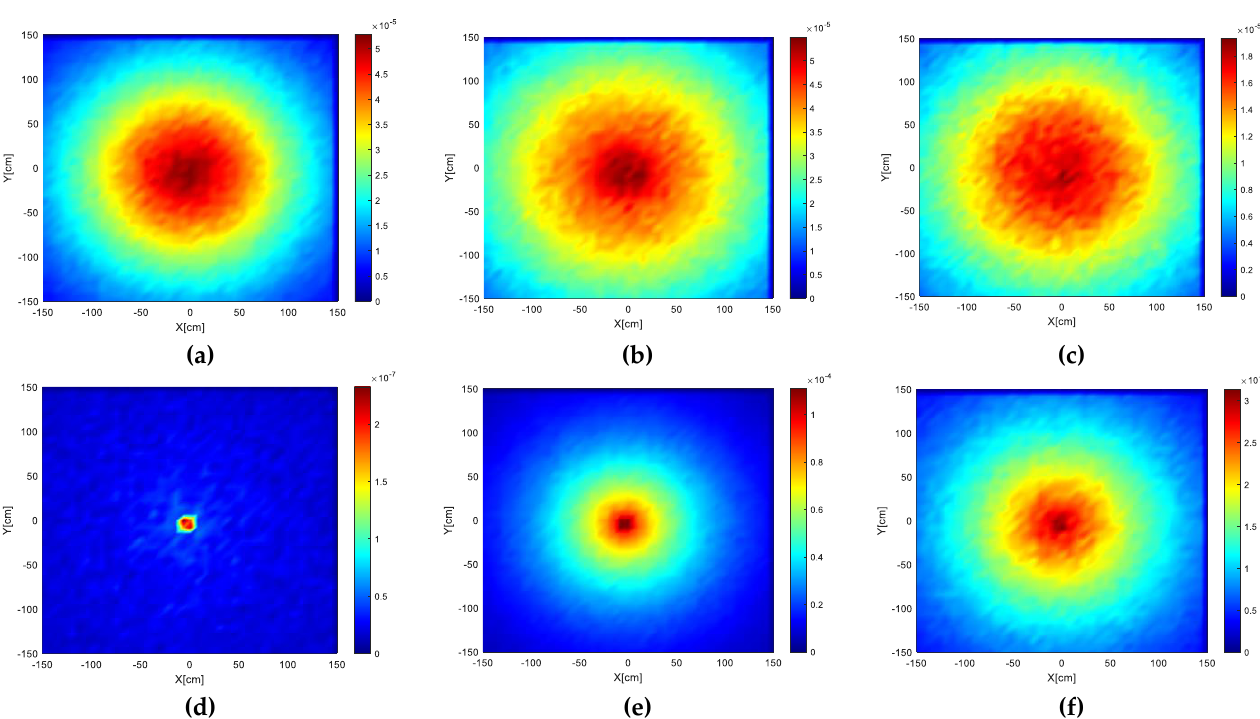
Figure 6. Illustration of CIR histogram of diffusive and collimated links for coastal & harbor water.